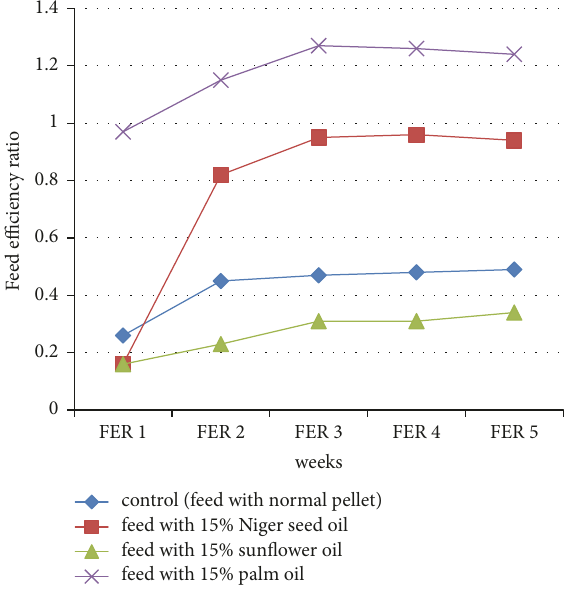
Figure 3: The characteristics of feed efficiency ratio (FER) of experimental animals (Wistar albino rats) (FER1: FER of rats in the first one week; FER2: FER of rats in the 2nd two weeks; FER3: FER of rats in the 3rd two weeks; FER4 : FER of rats in the 4th two weeks; FER5: FER of rats in the final 8th